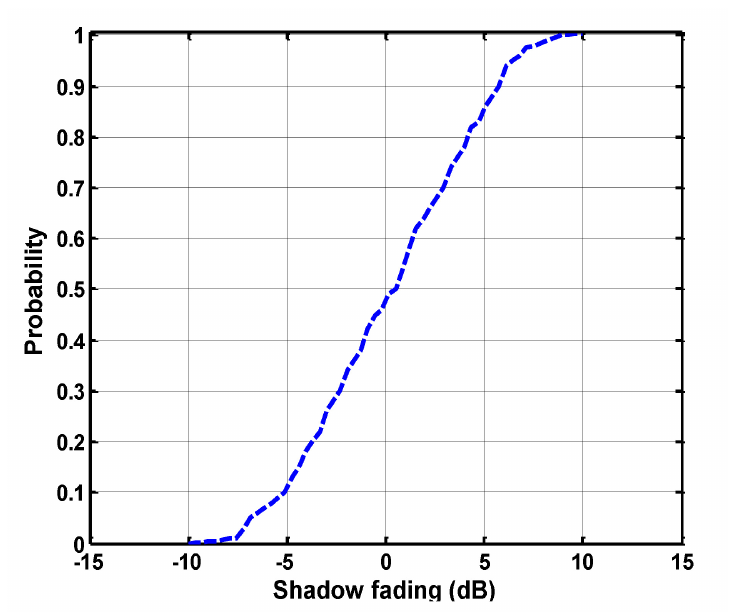
Figure 11. Cumulative distribution function of shadow